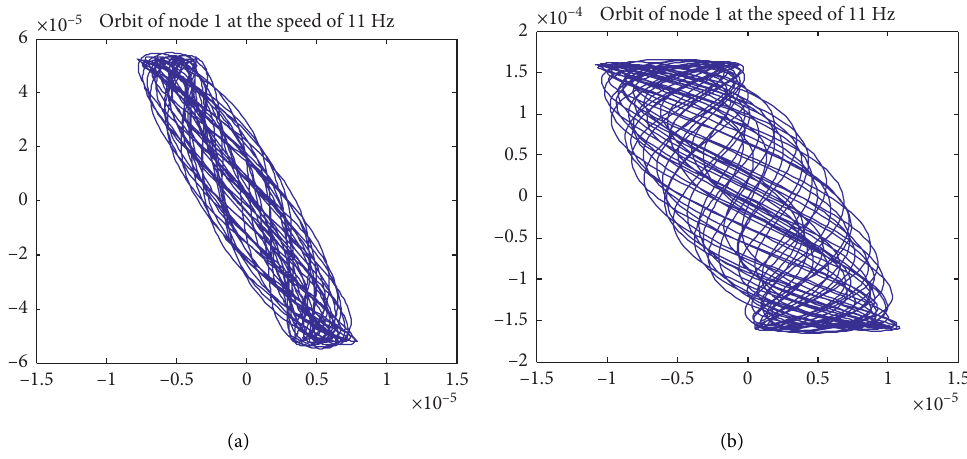
Figure 20: Orbits of bearing 1 at different misalignment ( Ω